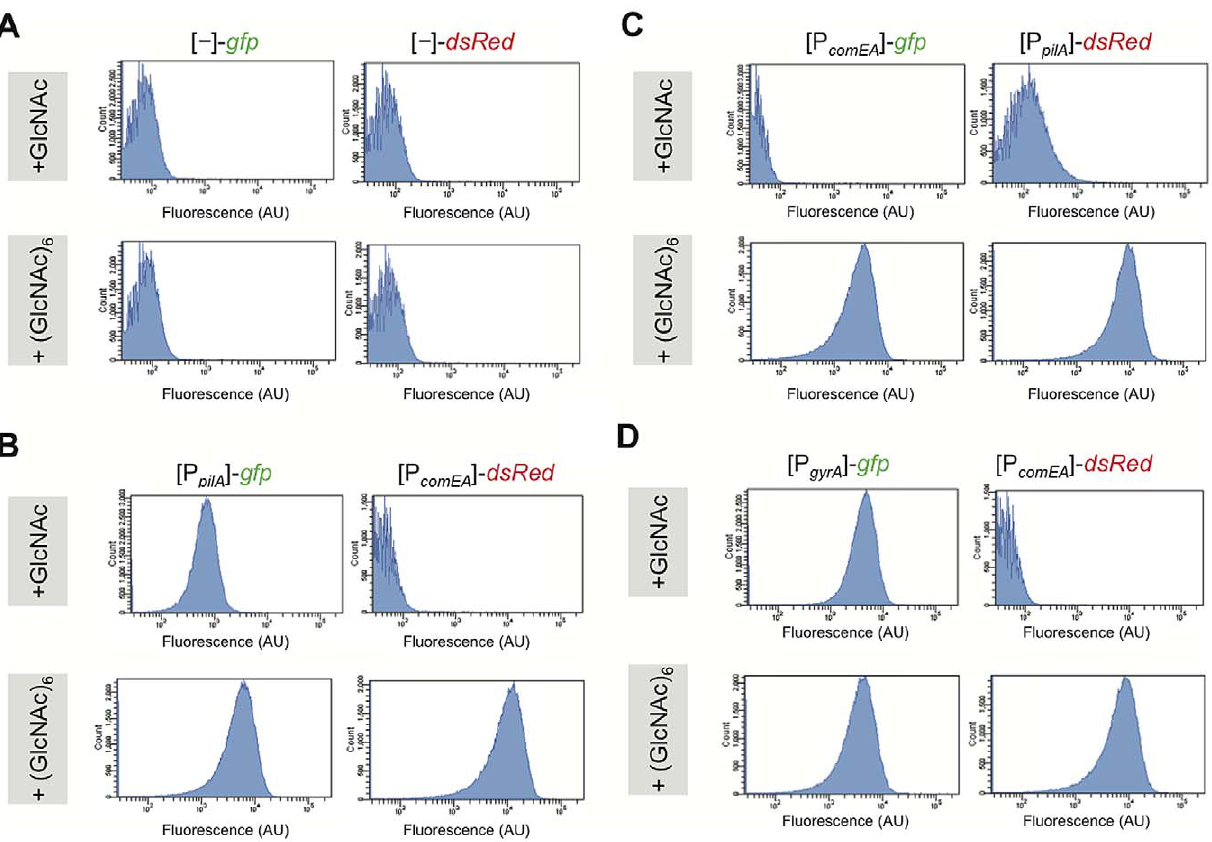
Figure 2. Competence genes are expressed by the majority of cells under homogeneous competence-inducing conditions. V. cholerae strains were grown aerobically in defined artificial seawater medium with the addition of either N-acetylglucosamine (GlcNAc) or hexa-N- acetylchitohexaose (GlcNAc) 6 as sole carbon source. The latter is known as a potent inducer of natural competence/transformation [11]. Competence gene expression was quantified for fluorescence intensities using flow cytometry. Reporter fusions are indicated above each panel. Panel A: promoter-less gfp and dsRed reporter; panel B: [P pilA ]- gfp /[P comEA ]- dsRed ; and panel C: [P comEA ]- gfp and [P pilA ]- dsRed. Panel D: [P gyrA ]- gfp /[P comEA ]- dsRed . The flow cytometry graphs indicate the number of cell counts on the y-axis and the fluorescence signal intensity (as arbitrary units, AU) on the x-axis.